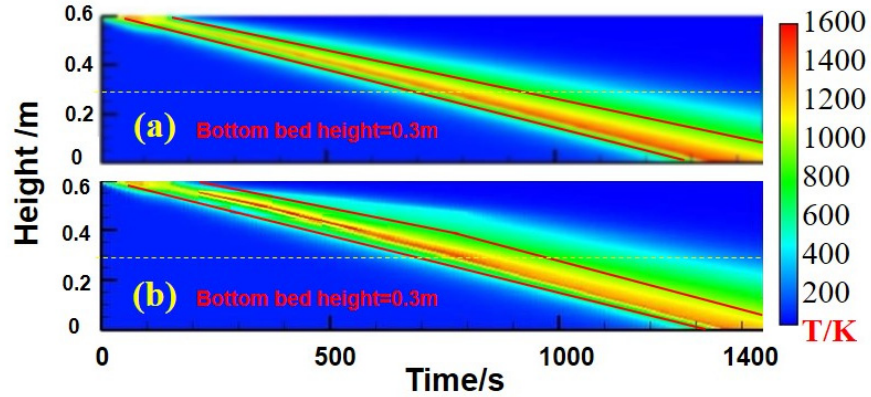
Figure 9. Temperature field in the sintering bed. ( a ) base case; ( b ) case I.